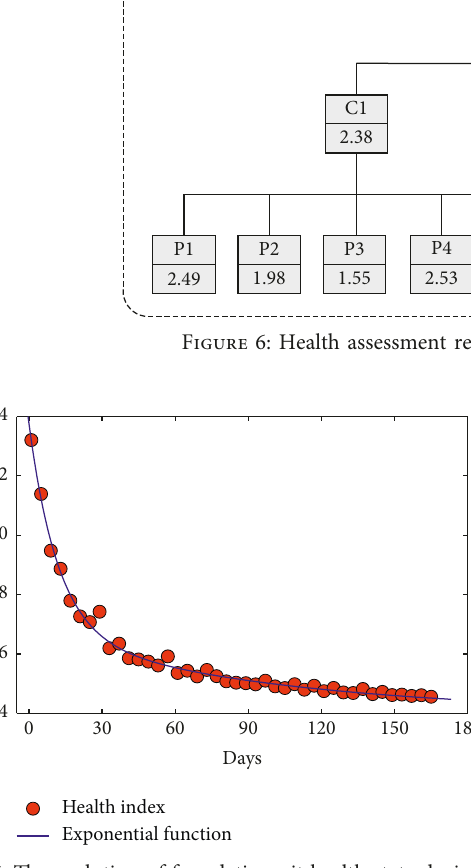
Figure 7: The evolution of foundation pit health state during the monitoring cycle.